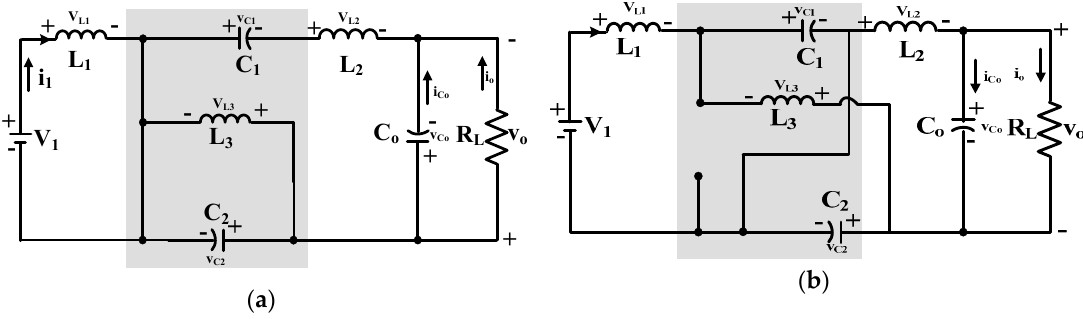
Figure 2. Circuit configuration ( a ) ON state; ( b ) OFF state.